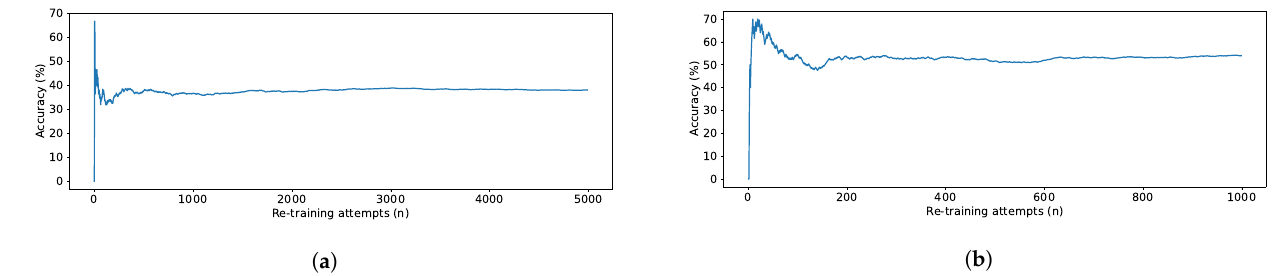
Figure 6. ( a ) Prediction accuracy improvement over time for TUG with difficulty to walk (one of the difficulties that are misclassified in 30% of the cases) and geriatric classification used 5000 times by individual 1, and ( b ) prediction accuracy improvement over time for TUG performed normally (a non-difficulty that is misclassified as fast in 71% of the cases) 1000 times by individual 3 classified as dementia severe .